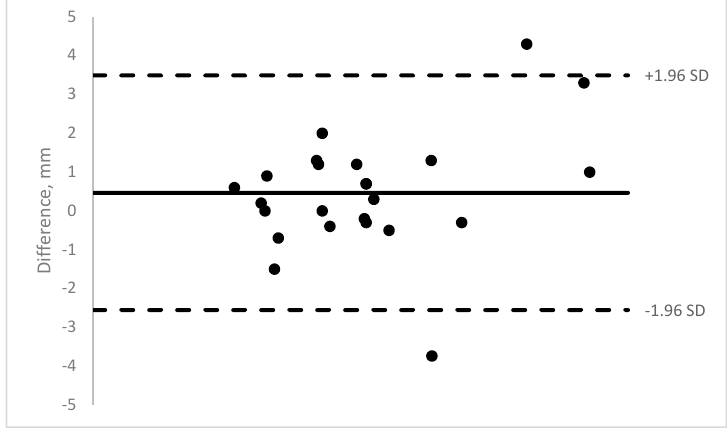
Figure 4. Rescan Bland–Altman plot of intra-operative measurements versus OCT measurement.